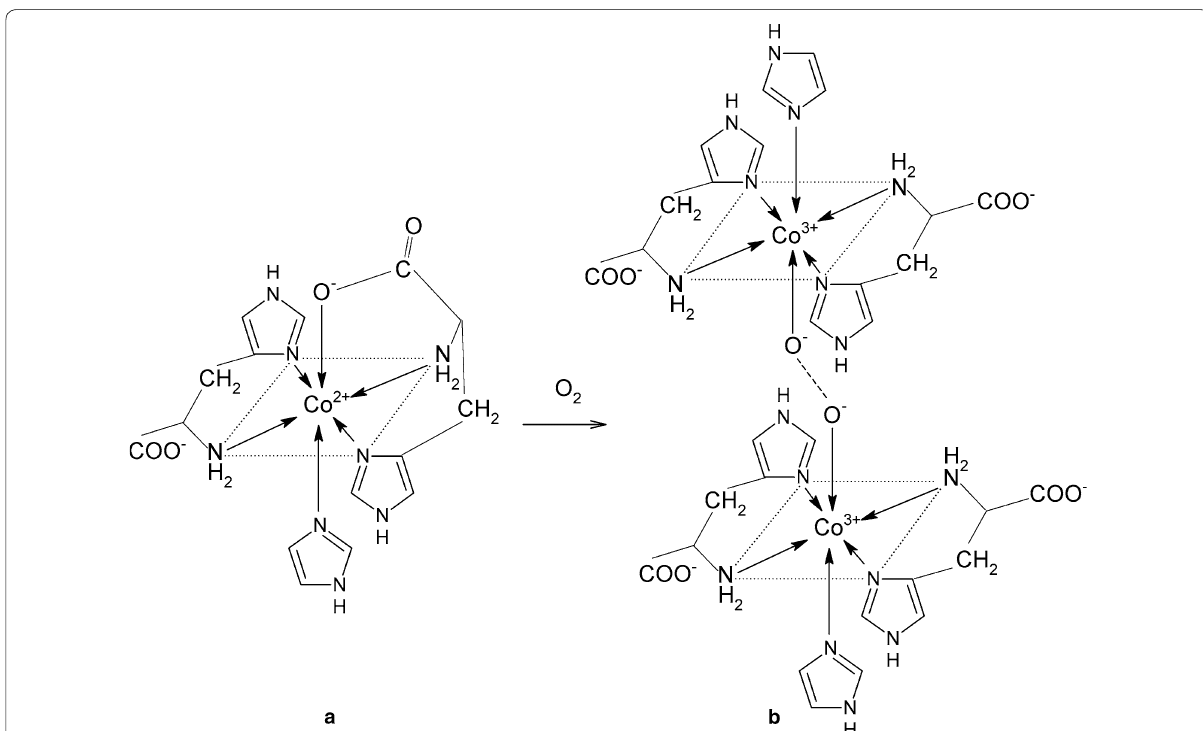
Fig. 5 Coordination modes in the Co(II)–amac–Himid system with amac dioxygen adduct